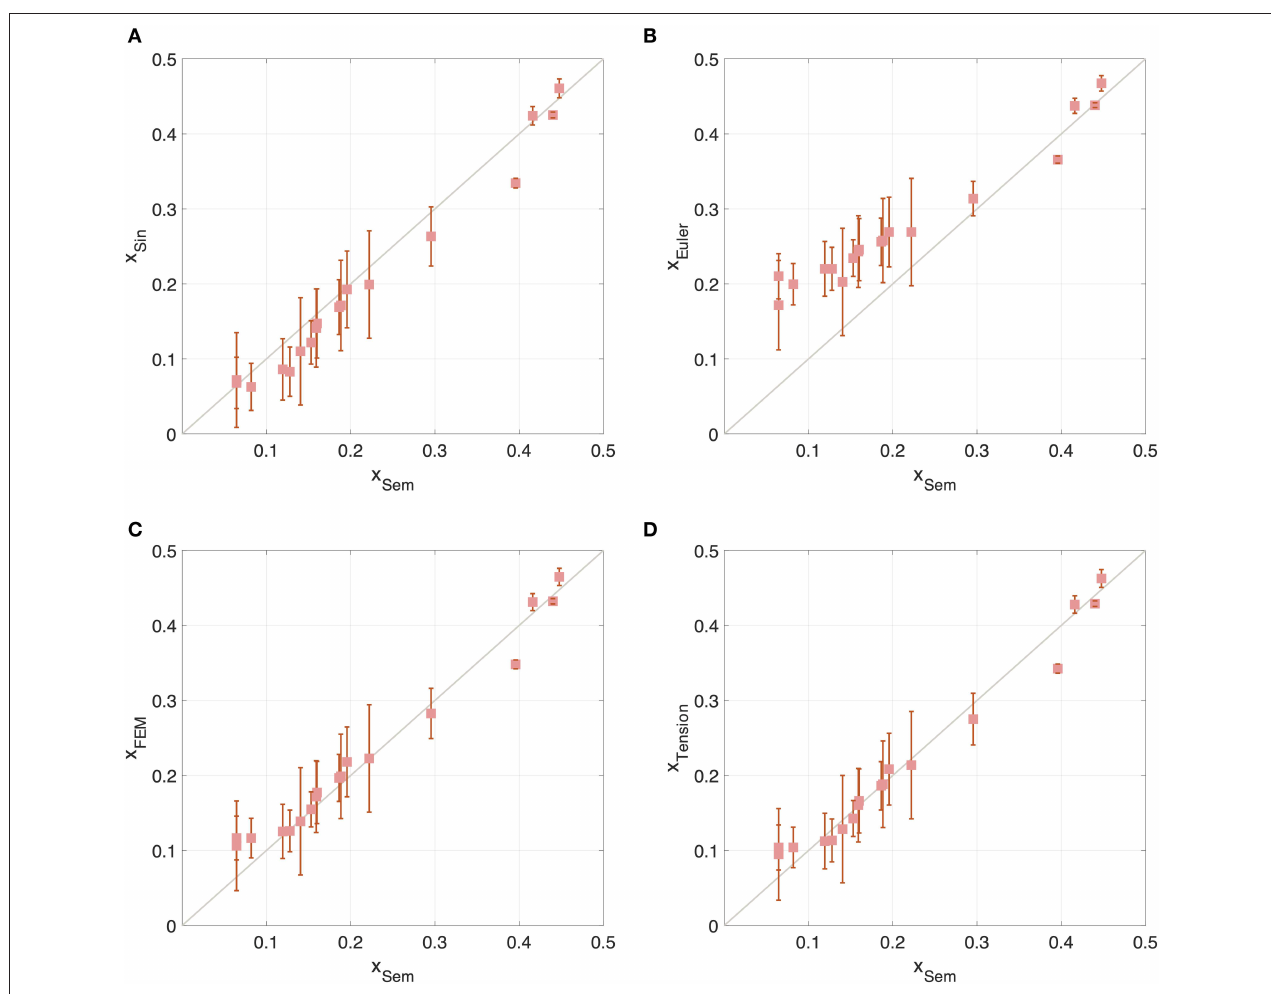
FIGURE 4 | Comparison of position values obtained by SEM characterization (x-axis) along the normalized beam length, and those obtained by NEMS (y-axis) using various mode shapes, (A) sinusoidal, (B) Euler-Bernoulli beam theory, (C) FEM simulation, and (D) the analytical solution with tension term. The data shown here correspond to the 20 µ m